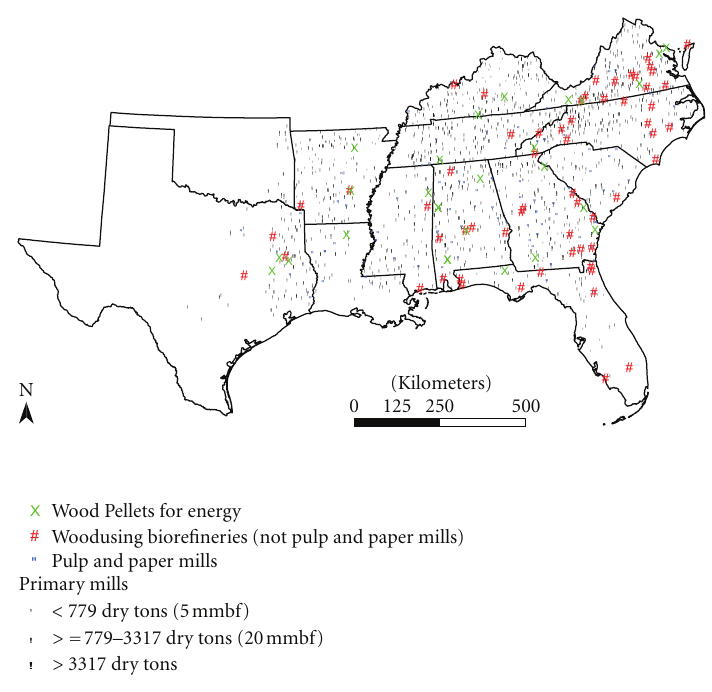
Figure 3: Primary wood-using facilities in the 13-state study